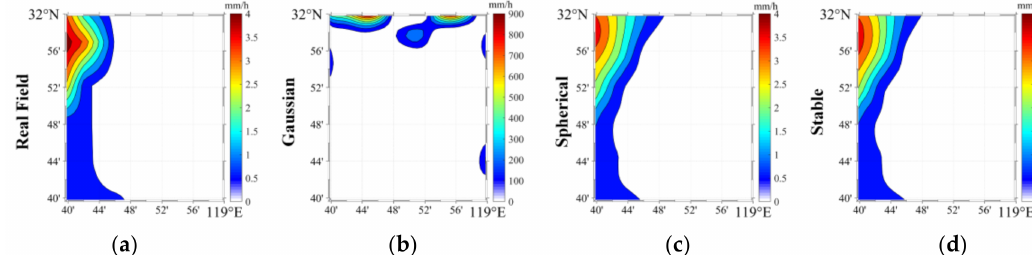
Figure 14. ( a ) A rainfall field with high kurtosis and reconstructed results by using ( b ) gaussian, ( c ) spherical and ( d ) stable